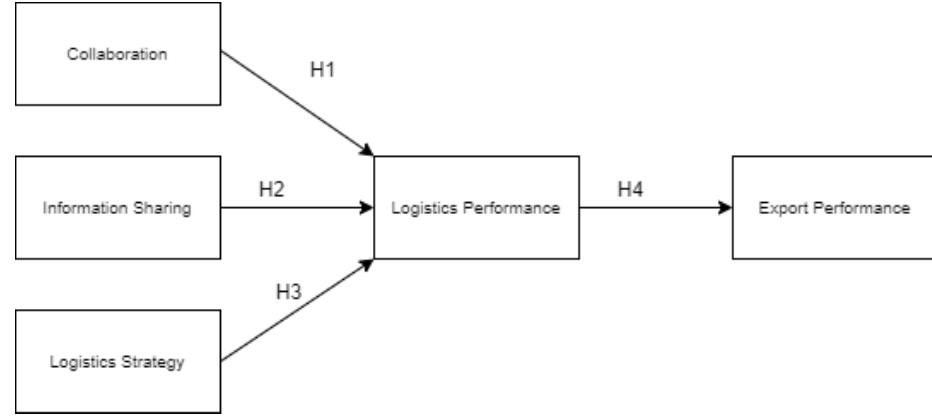
Figure 1: Conceptual Model of the Study; Source : Authors